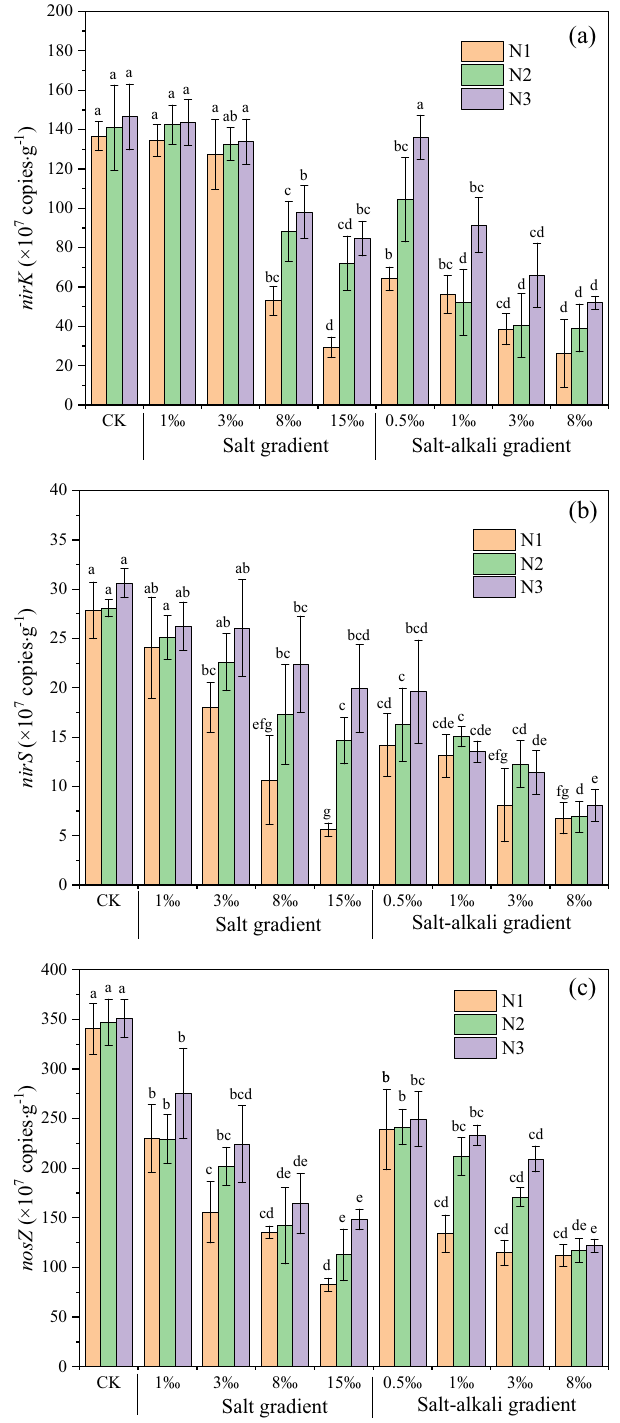
Figure 2. Abundance of the denitrifying functional genes nirK ( a ), nirS ( b ), and nosZ ( c ) under various salt/ salt-alkali gradients and urea levels. The different letters above the bars indicate significant differences between the treatments within salt/salt-alkali gradients under the same urea level. Note: N1, N2, and N3 represent 0.05‰, 0.10‰ and 0.15‰ urea addition, respectively. Bars represent abundance of the denitrifying functional genes; error bars denote standard deviations of three independent repetitions (n = 3). Different letters indicate the significant differences among treatments under the same nitrogen condition (p < 0.05, one-way ANOVA followed by Duncan’s